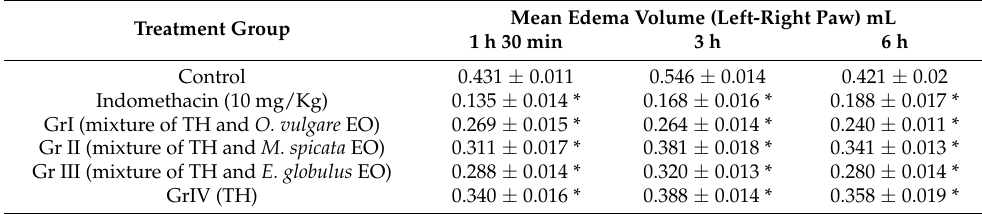
Table 6. Effect of thyme honey and mixtures on carrageenan-induced rat paw edema.